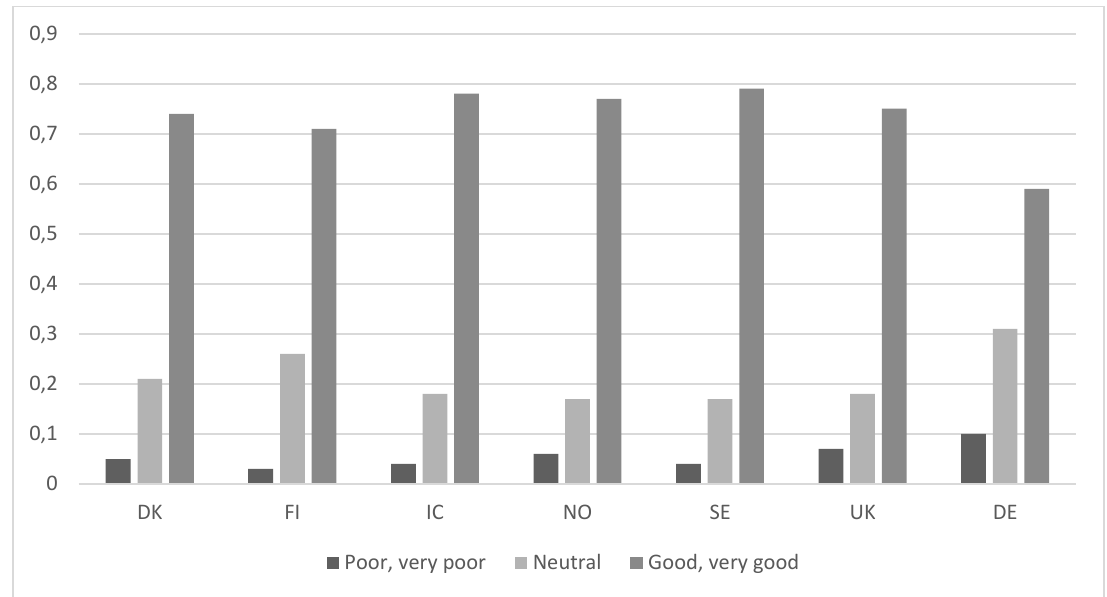
Source: European Social Survey 2012 (European Social Survey,